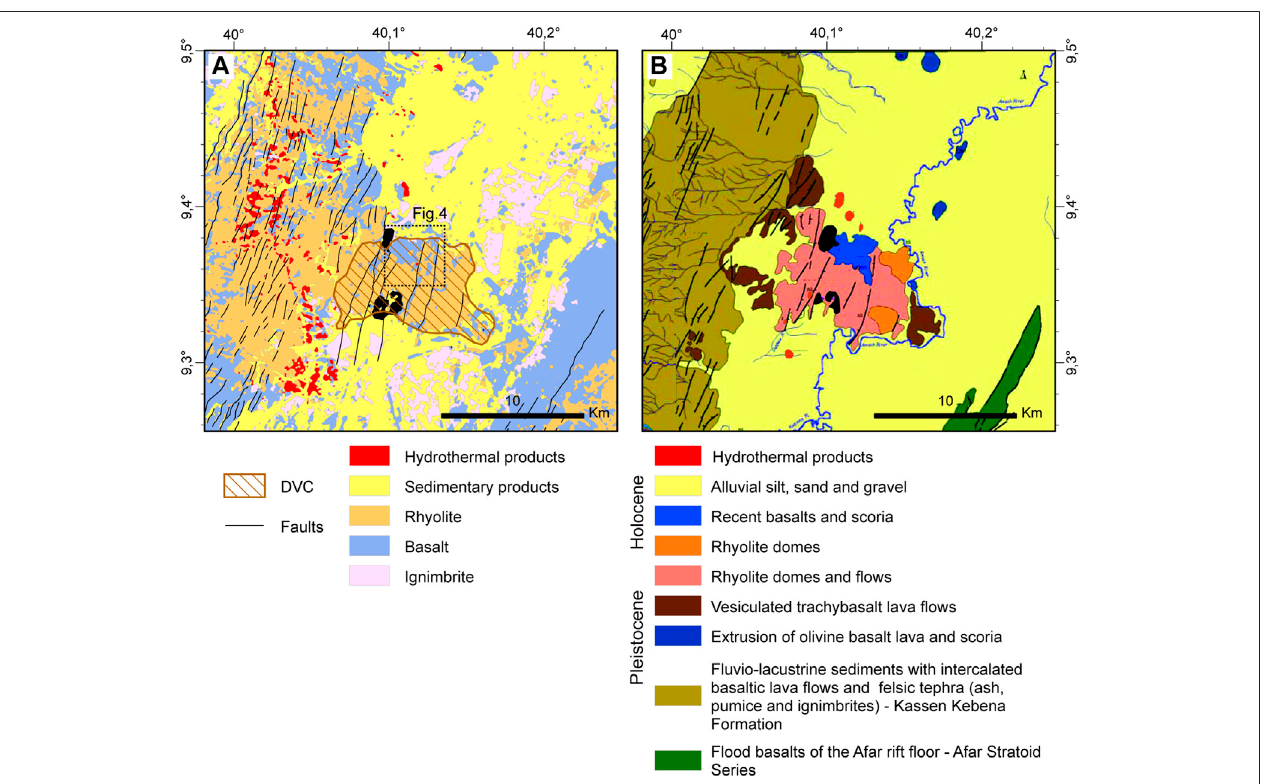
FIGURE 3 | (A) Lithological map form supervised classi fi cation of Landsat 8 multispectral image of the Dofan area. In the image the area that corresponds to the photos in Figure 4 is shown. (B) Geological map from fi eld observations by Chernet (2005). In both images the hydrothermal deposits are mapped in red.